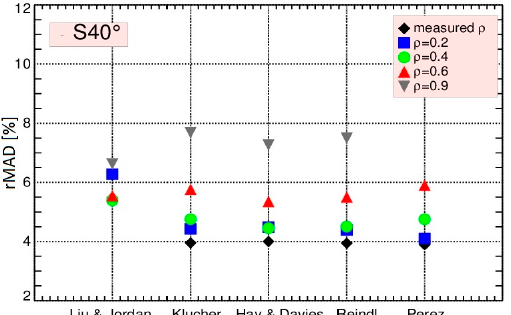
Figure 6. Dependence of the rMAD for the five models on the spectrally constant ground albedo. The tilted irradiance has been calculated based on NREL data for 40° S tilt, using different constant albedo values (0.2, 0.4, 0.6 and 0.9) and measured values at NREL. The models show lower deviations to the measurement if measured albedo values are used.